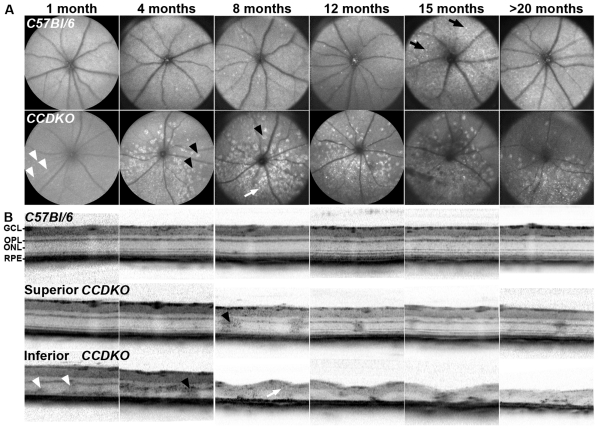

CCDKO mice show an early onset, focal inferior retinal degeneration starting in the outer retina which subsequently leads to a breakdown of retinal layering in the affected area with age.
In vivo assessment of the retinal degeneration of CCDKO mice and age-matched C57Bl/6 wildtype mice at 1,4,8,12,15 and older than 20 months of age using autofluorescence scanning laser ophthalmoscopy (A) and optical coherence tomography (B). Note the weak autofluorescent fundus lesions in CCDKO mice visible as early as 1 month (A) which correlate with the observation of an abnormal signal in the inferior OCT image at the same age (B) and suggests an early pathological event in the outer retina as the basis of the degeneration in this model. Corresponding signals in AF-SLO and OCT images are labelled identically. White arrowheads: small early inner retinal autofluorescent lesion, black arrowheads: discrete disciform autofluorescent lesion, white arrow: “confluent” autofluorescent lesion in AF-SLO represents loss of retinal layering and severe retinal degeneration, black arrow: discrete autofluorescent spot-like lesion. GCL: ganglion cell layer, OPL: outer plexiform layer, ONL: outer nuclear layer, RPE: retinal pigment epithelium.